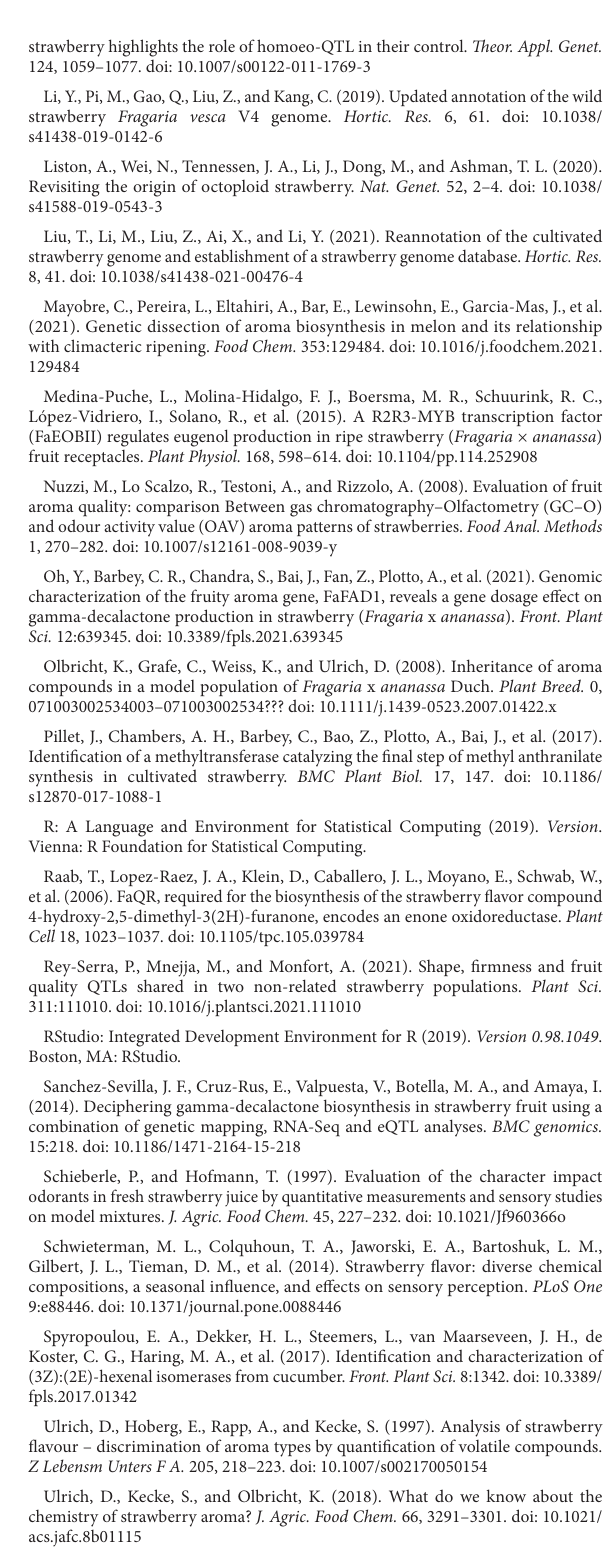
segregating (blue) and “FD54” segregating (yellow). Right: Boxplot with each sample represented as dots and the blue square the average of each group. Significant levels <0.001 (***), <0.01 (**) and <0.05